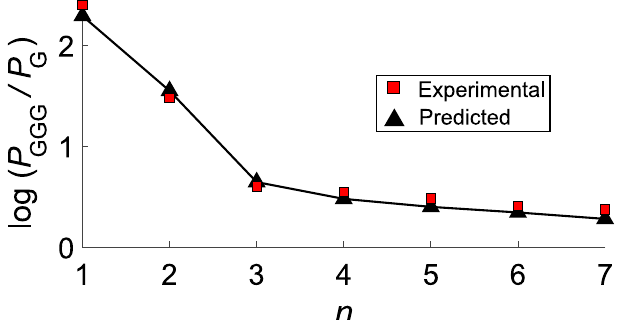
Figure 13. Predicted (black triangles) and experimental (red squares) P GGG / P G yield ratios for the HT in d -G(T) n GGG as a function of the number of bases separating the donor and the acceptor G sites. Computed values have been obtained by setting k 12 = 10 10 s − 1 for all the investigated sequences, obtained by solving the ODEs equations for the kinetic scheme of Figure 10. Adapted with permission from J. Phys. Chem. Lett. 2019 , 10 , 1845–1851. Copyright (2019) American Chemical